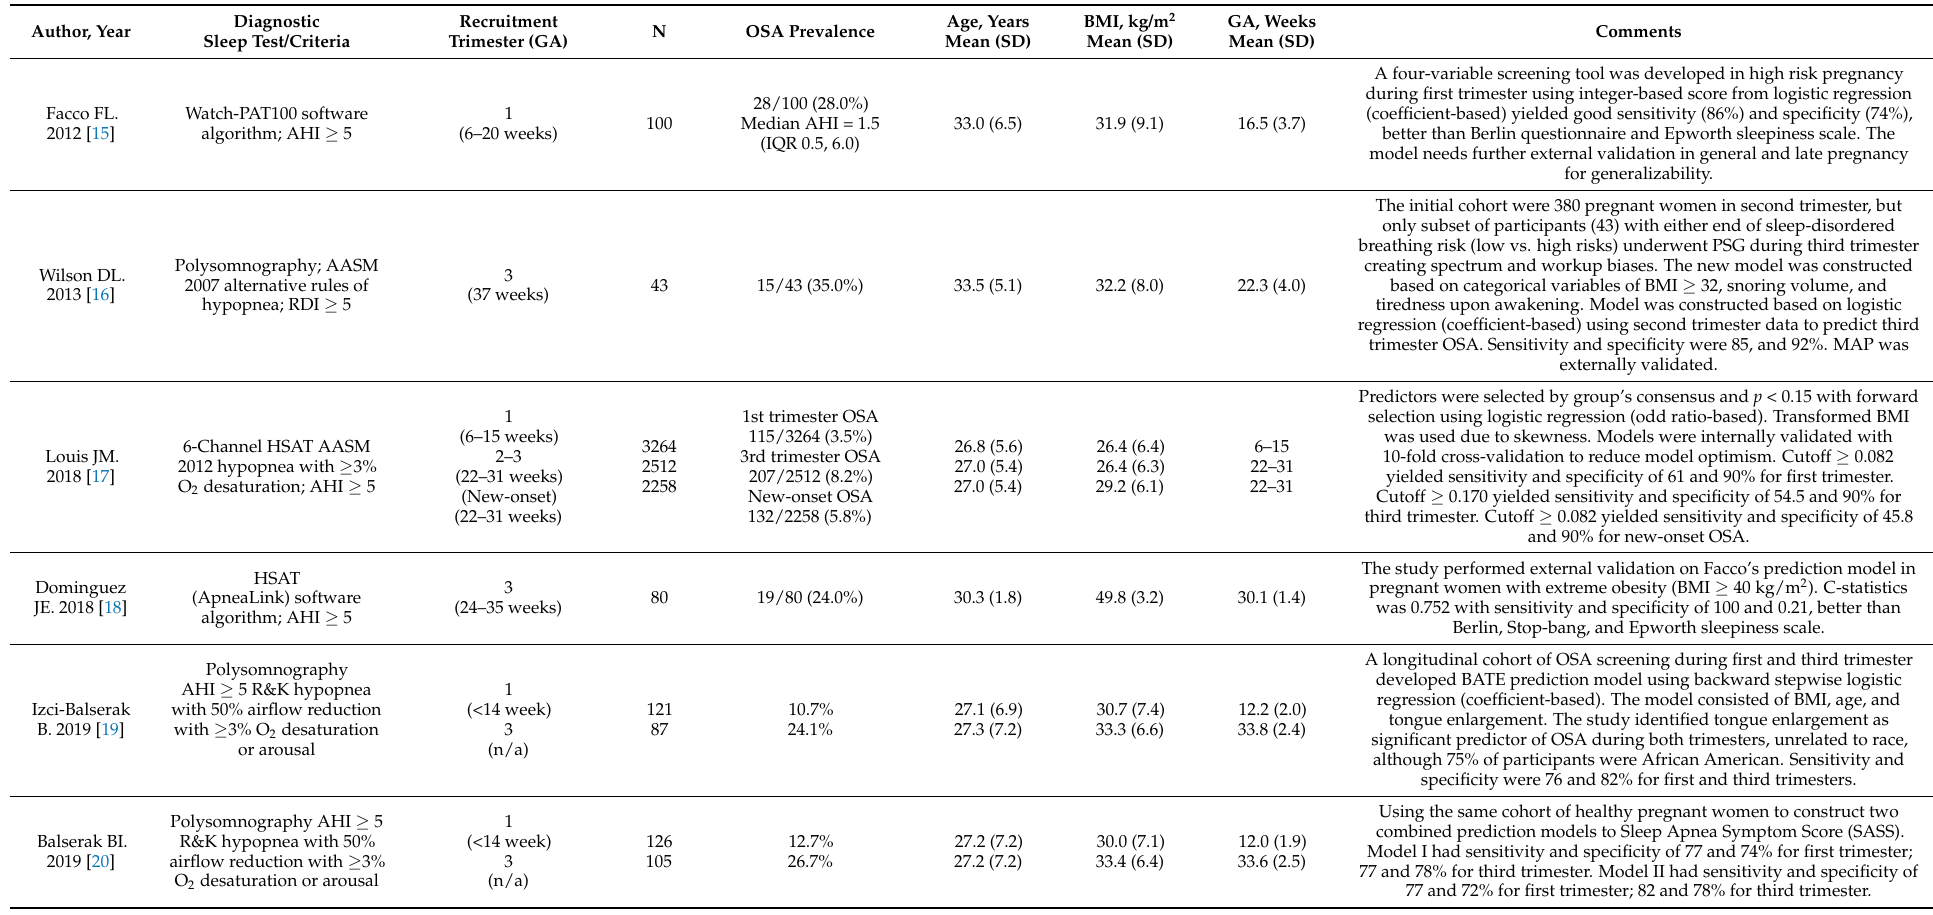
Table 2. Characteristics of studies that developed prediction model for gestational obstructive sleep